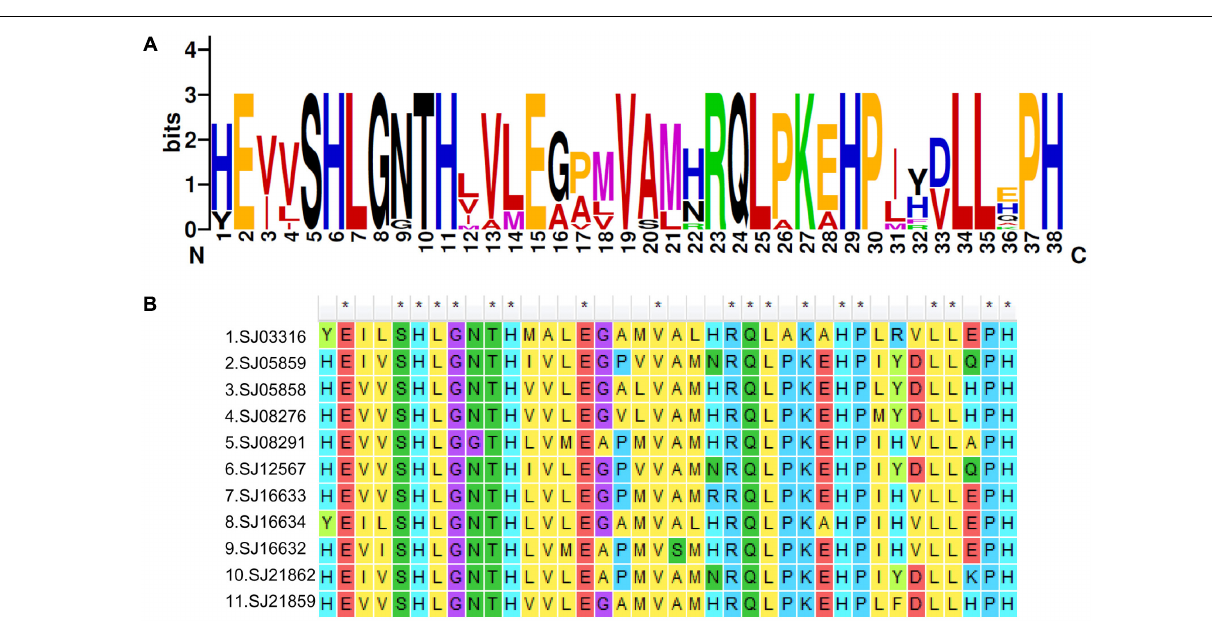
FIGURE 5 | A 38-residue motif among S. japonica LOX sequences. (A) The logo was created with 11 S. japonica LOX sequences. The overall height of each stack indicates the sequence conservation at that position and the height of each residue letter indicates the relative frequency of the corresponding amino acid residue. (B) Sequence alignments of 38-residue motifs in S. japonica LOX